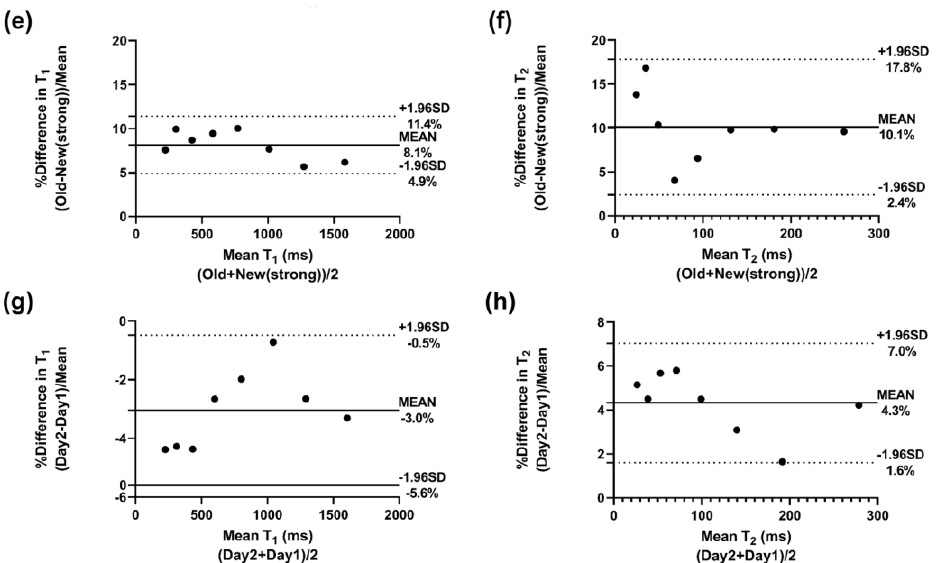
Figure 4. Bland–Altman analyses of T 1 and T 2 values obtained from the ISMRM/NIST MRI system phantom on the two scanners (old and new) showing patterns of bias and limits of agreement. ( a , b ) Comparison of the two evaluated spiral trajectories on the new scanner, the modified spiral with ‘weak’ gradients and the spiral conventionally used for MRF with ‘strong’ gradients. ( c , d ) Comparison of the new scanner with ‘weak gradient’ spiral versus the old scanner with the same ‘weak gradient’ spiral. ( e , f ) Comparison of the new scanner with ‘strong gradient’ spiral versus the old scanner with the ‘weak gradient’ spiral. ( g , h ) Comparison of T 1 and T 2 measurements on the old scanner across different days (test−retest assessment of reproducibility).